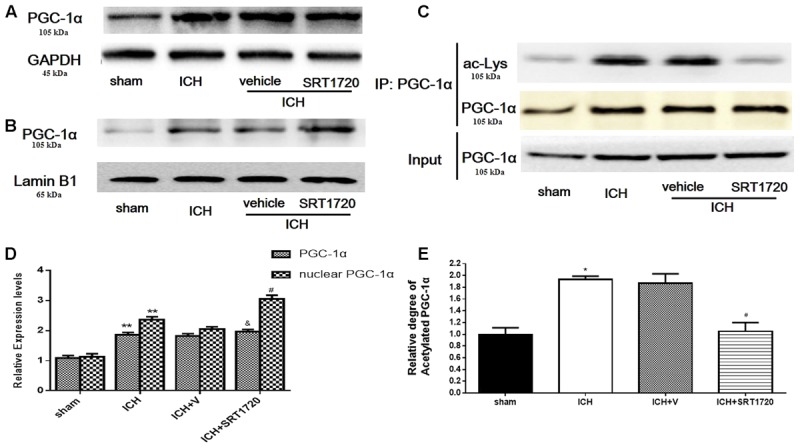
SIRT1 activation induced deacetylation of PGC-1α after ICH. (A) Total PGC-1α protein in brain tissue 48 h after ICH assessed with immunoblot. Relative protein band density value of total PGC-1α was calculated as the ratio of protein of interest to that of GAPDH. (B) Nuclear PGC-1α 48 h after ICH assessed with immunoblot. Relative protein band density value of nuclear PGC-1α was calculated as the ratio of protein of interest to that of lamin B1. (C) Acetylation of PGC-1α 48 h after ICH as measured by immunoprecipitation. Quantification of (A–C) is shown in (D,E), respectively. Error bars represent mean ± SEM. (∗∗P < 0.01 vs. sham; #P < 0.05, ##P < 0.01 vs. ICH; &P > 0.05 vs. ICH). n = 4 in sham group, and n = 6 in other groups.